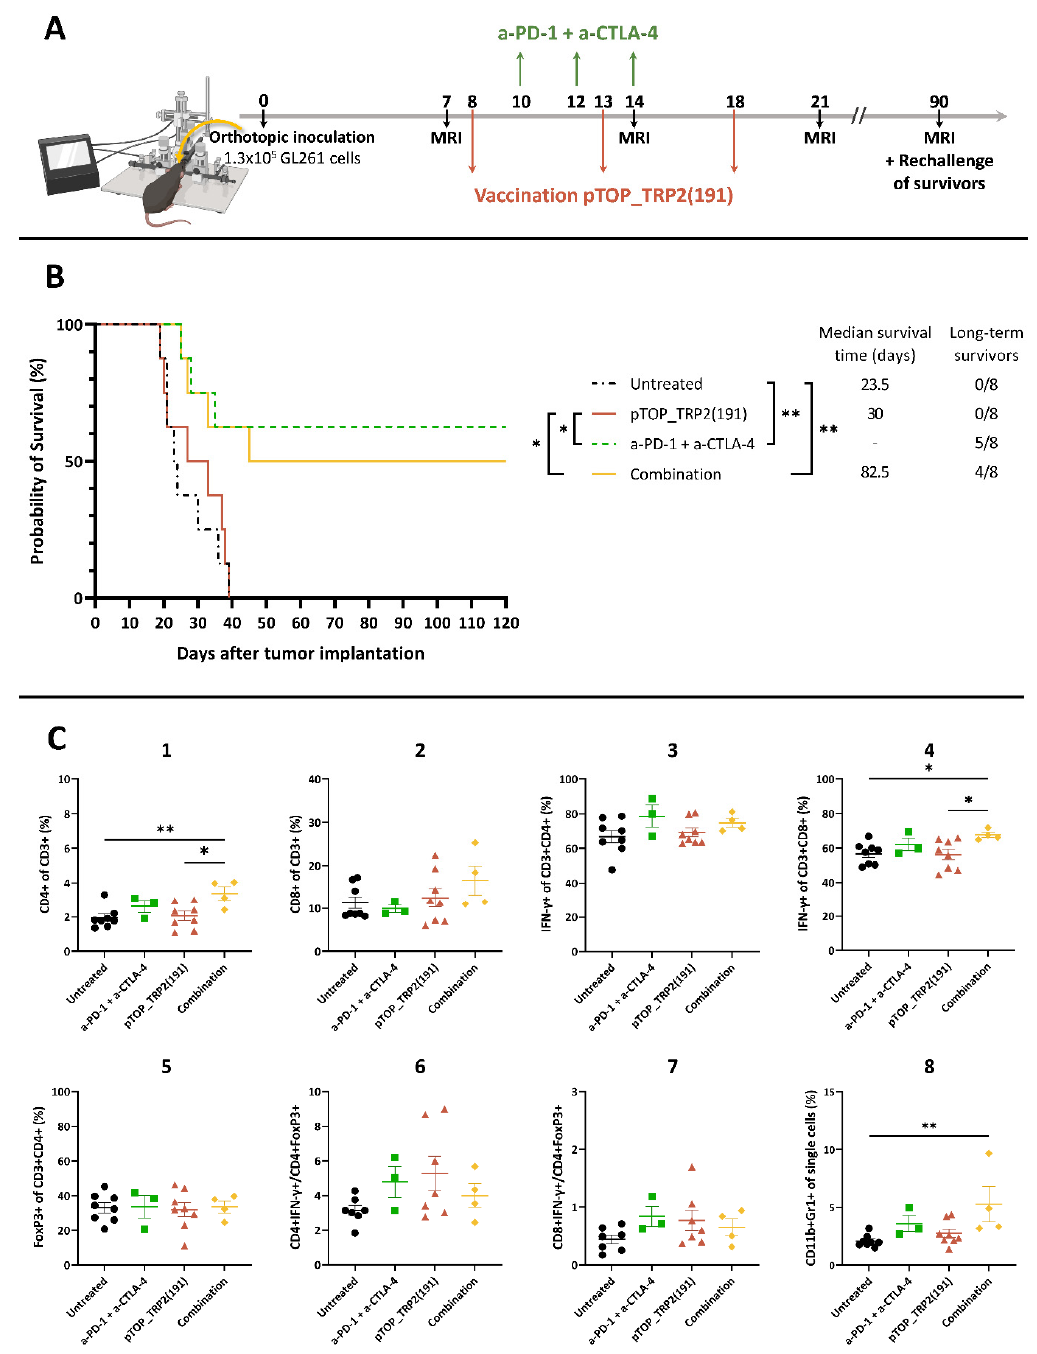
Figure 4. Survival of GL261-bearing mice following treatment with pTOP, anti-PD-1 and anti-CTLA-4 mAbs or the combination. ( A ) Schematic protocol of experiments. Timing is expressed in days. ( B ) Survival curves following treatment with pTOP, ICBs or combination; n = 8. Statistical analyses of survival curves were performed using Mantel–Cox test (* p < 0.05; ** p < 0.01). ( C ) FACS analysis of immune cells in the brain at endpoints. Values are mean ± SEM; n = 3–8. Statistical analyses were performed using one-way ANOVA with Dunnet’s multiple comparison test (* p < 0.05; ** p < 0.01, compared to the specified group). Untreated: black circle; anti-PD-1 + anti-CTLA-4: green square; pTOP: red triangle; combination: yellow